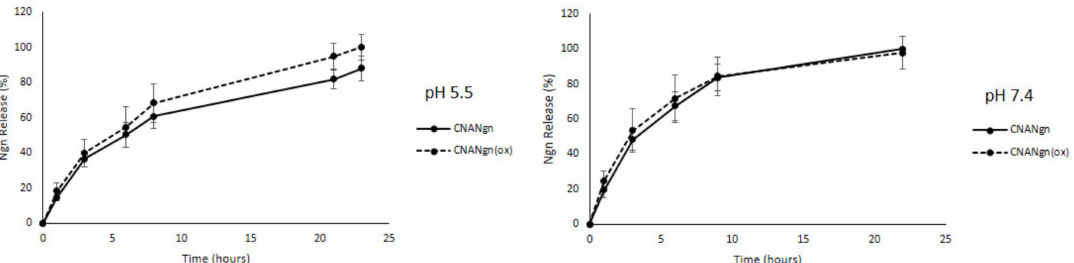
Figure 6. Ngn (naringenin) concentration released ( µ g / mL) from CNANgn (CNA treated with Ngn) and CNANgn(ox) (CNA treated with Ngn in oxidative environment) at pH 5.5 and 7.4. The data represents the mean ± standard deviation of n =